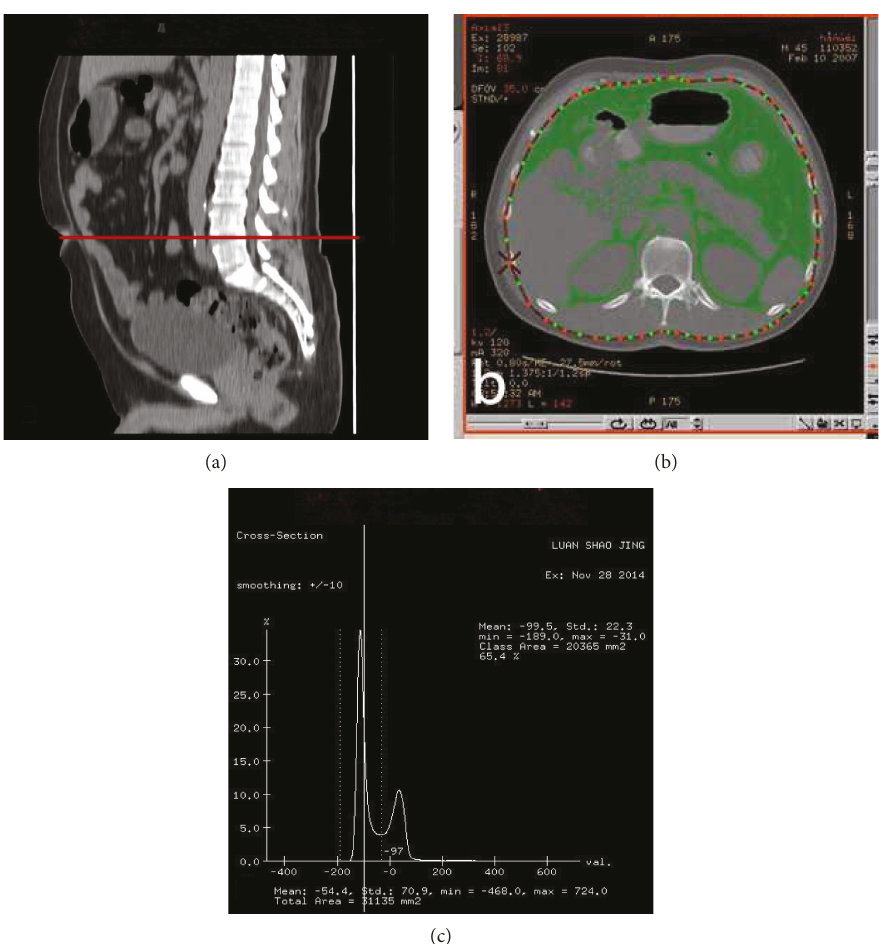
Figure 1: Quanti fi cation of visceral fat area: (a) select CT images at the umbilical level to calculate the visceral fat area; (b) with the mouse to drag the coil marked visceral tissue region; (c) we can determine the threshold by dragging the dotted line in the view. Adipose tissue was determined by setting the attenuation level within the range of − 190 to − 30 Houns fi eld units. VFA was quanti fi ed automatically by the software.